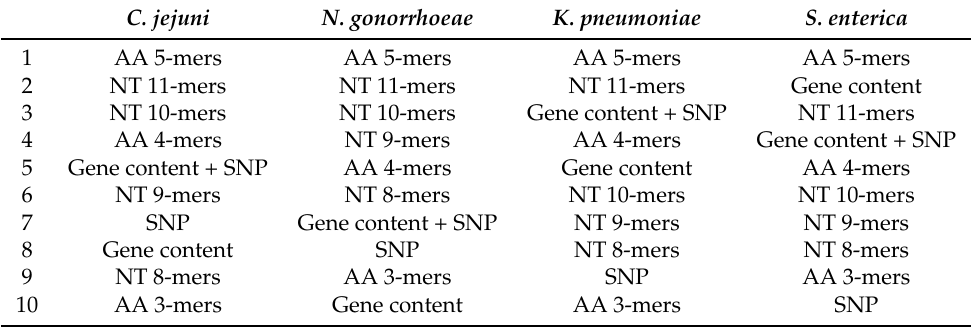
Table 4. Rankings of average accuracy among different methods for each